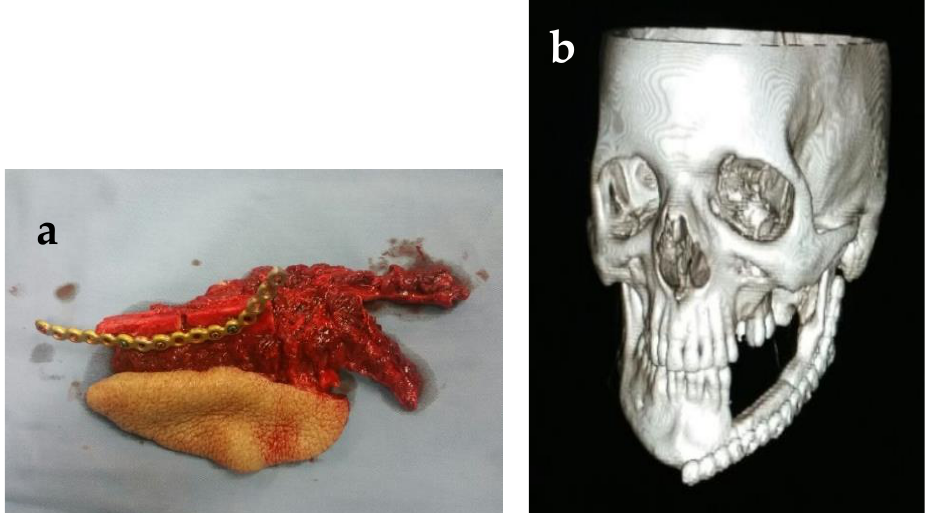
Figure 3. ( a , b ) Fibula graft, 3D computed tomography of patient showing hemimandibular defect reconstructed with fibula placed at the basal bone level.